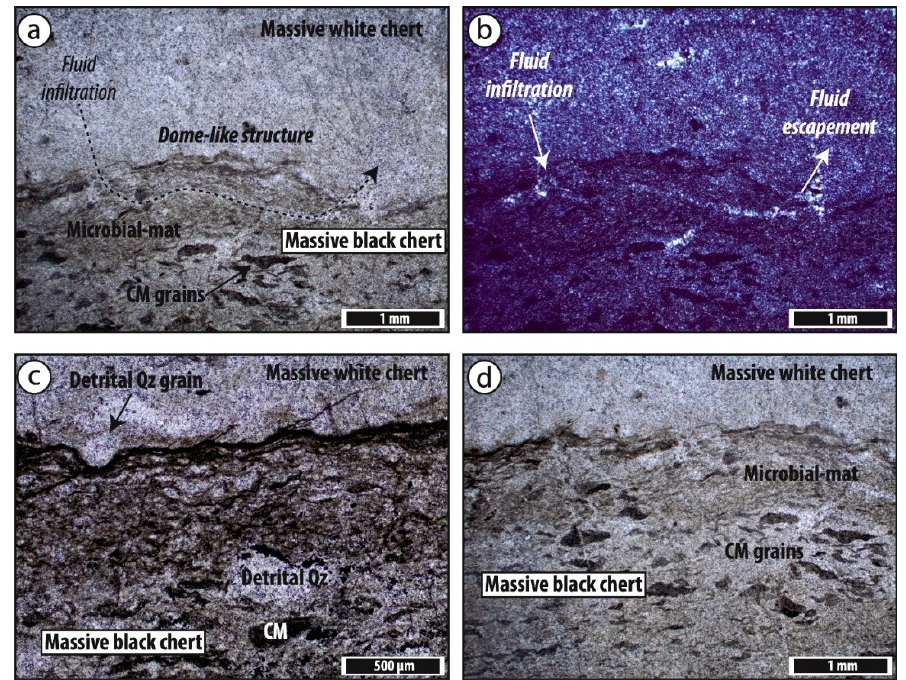
Figure 11. Characteristics of the contact between massive black and white chert layers. ( a ) Microbial mat-like textures follow the contact and are locally cut by thin, interconnected microquartz veins. The dome structure likely formed early, by density-induced, soft-deformation of the contact. ( b , c , d ) Sharp and irregular contacts characterized by densely packed zones of carbonaceous matter. (CM = Carbonaceous matter, Qz = quartz).